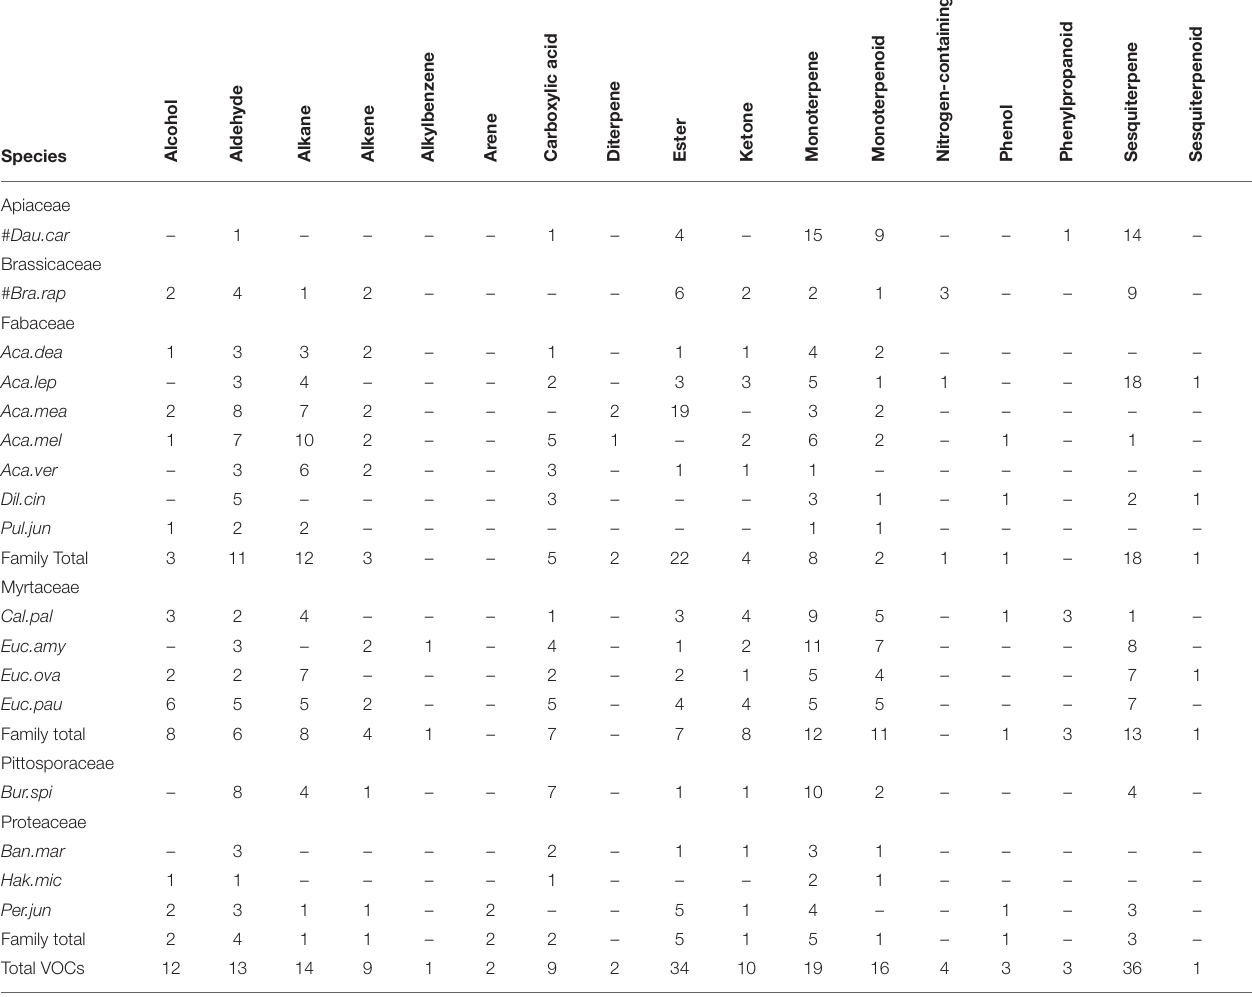
TABLE 2 | Number of unique floral volatiles ordered against plant species, arranged by chemical